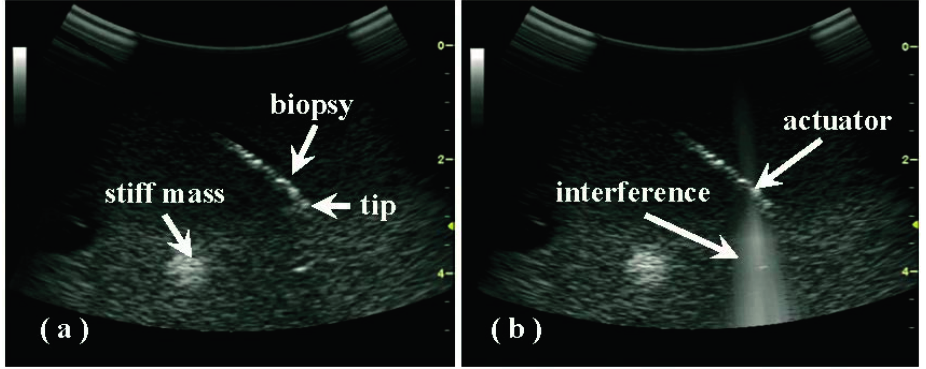
Figure 4. A comparison of sonography-guided biopsy in a breast gel phantom with both hyper- and hypo-echoic lesions ( a ) before and ( b ) after the activation of the mini actuator, where the interference generates bright lines.